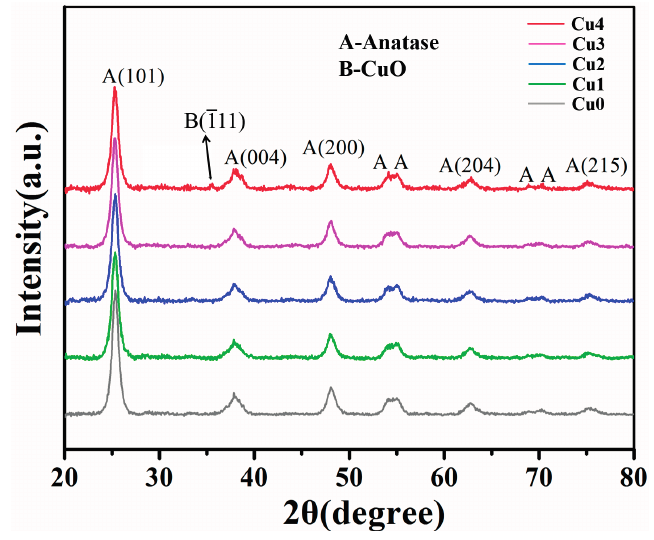
Figure 3. XRD results of the Cu0, Cu1, Cu2, Cu3 and Cu4